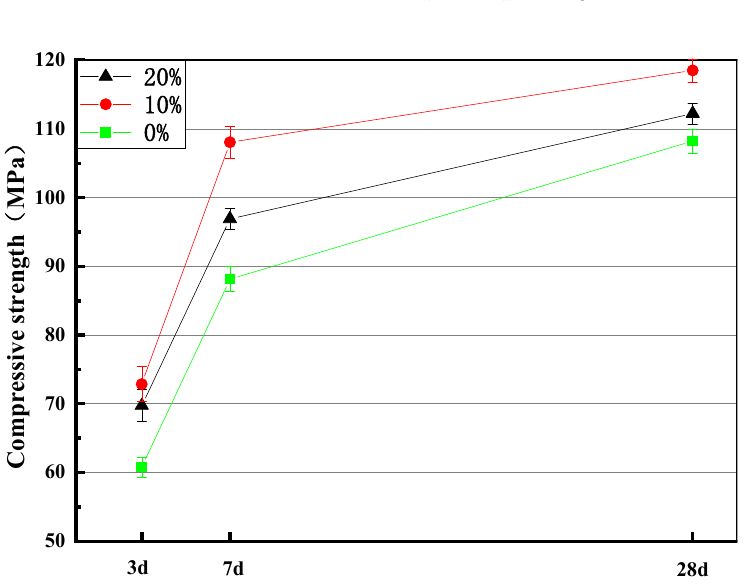
Figure 11. Compressive strength of specimens with different substitution rates.